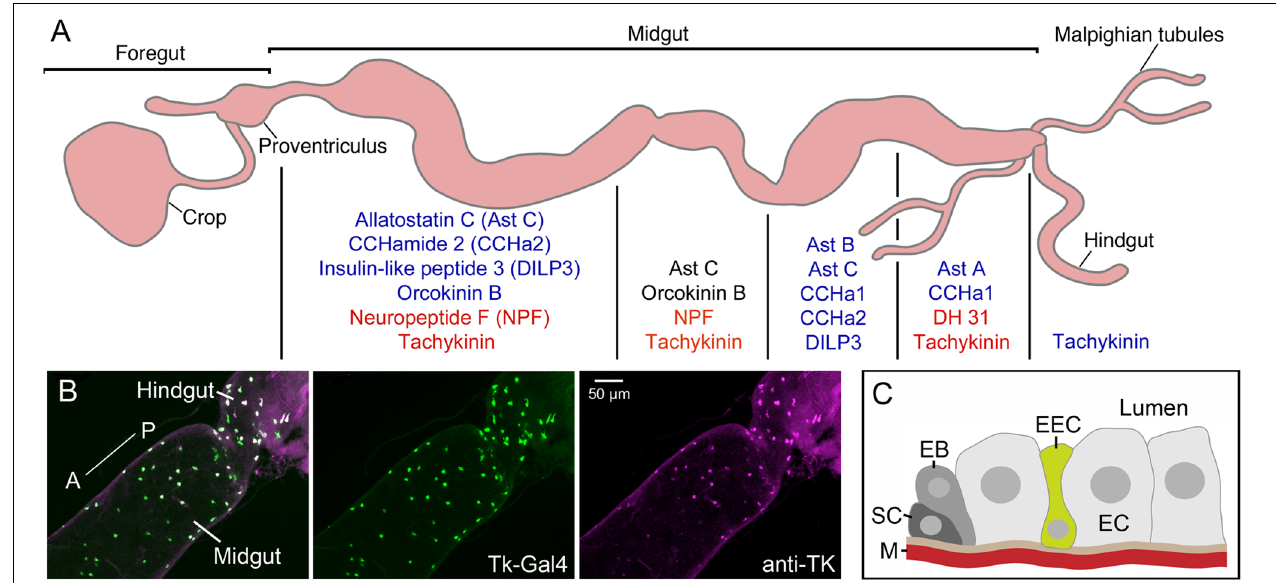
FIGURE 9 | Neuropeptides and peptide hormones in the Drosophila intestine. (A) In the midgut enteroendocrine cells (EECs) produce neuropeptides/peptide hormones in a region-specific manner. Four midgut regions are shown here [based on (Veenstra and Ida, 2014)]. Peptides produced are shown in blue text, and those that are colocalized in EECs in the different regions are shown in red or black text (NPF and tachykinin, AstC and orcokinin B, DH31 and tachykinin). DH31 is calcitonin-like diuretic hormone 31. There are also EECs producing tachykinin in the anterior hindgut. This figure is compiled from Veenstra et al. (2008); Veenstra and Ida (2014). (B) EECs in the posterior midgut and anterior hindgut produce tachykinin (TK) as demonstrated by Tk-Gal4 driven GFP (green) and antiserum to TK (magenta). From Liu et al. (2016b). (C) Schematic depiction of an EEC located between enterocytes (EC). The EECs may sense nutrients in the gut lumen and release peptide either locally in a paracrine fashion or into the circulation outside the muscle layer (M). The other cells shown are stem cells (SC) and enteroblasts (EB) that are responsible for renewal of the gut epithelium. This figure was redrawn from a figure in Lemaitre and Miguel-Aliaga